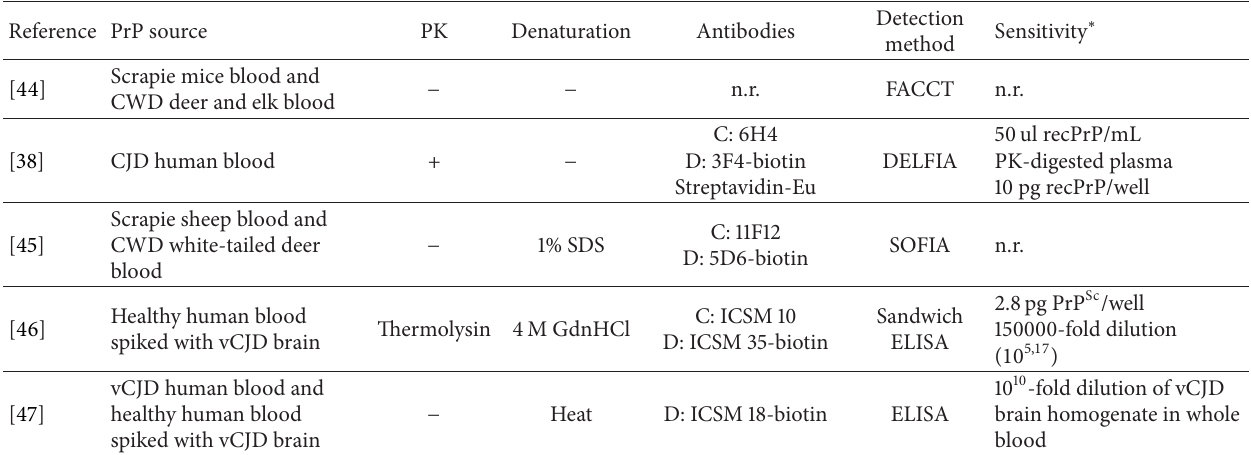
Table 2: Summary of the methods for detection of PrP Sc in